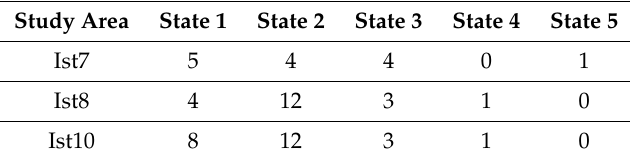
Table 11. Results fusion states of all five study